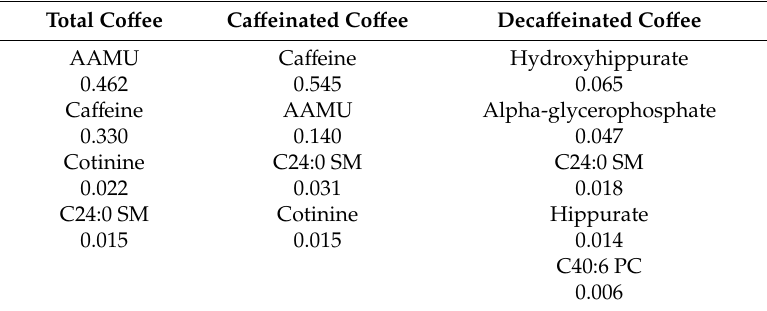
Table 2. Metabolites ranked from the highest to the lowest elastic net positive regression coe ffi cients for co ff ee and its types consumption.